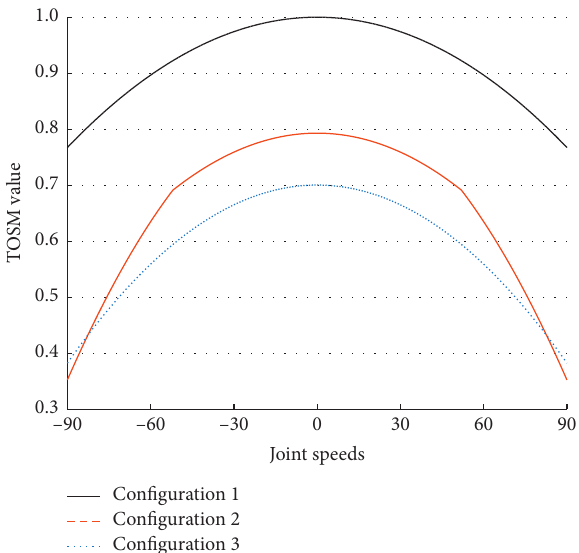
Figure 7: Variation of tip-over stability margin with joint speed in different configurations.